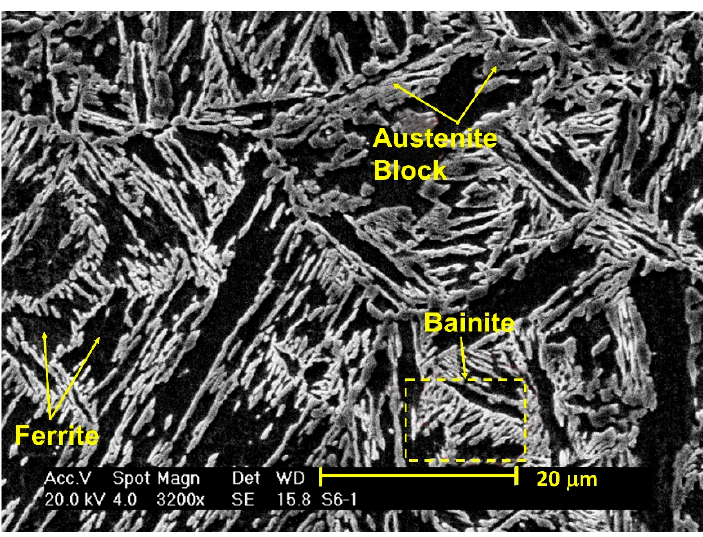
Figure 8. SEM image of M390-300 sample etched with nital 3%.